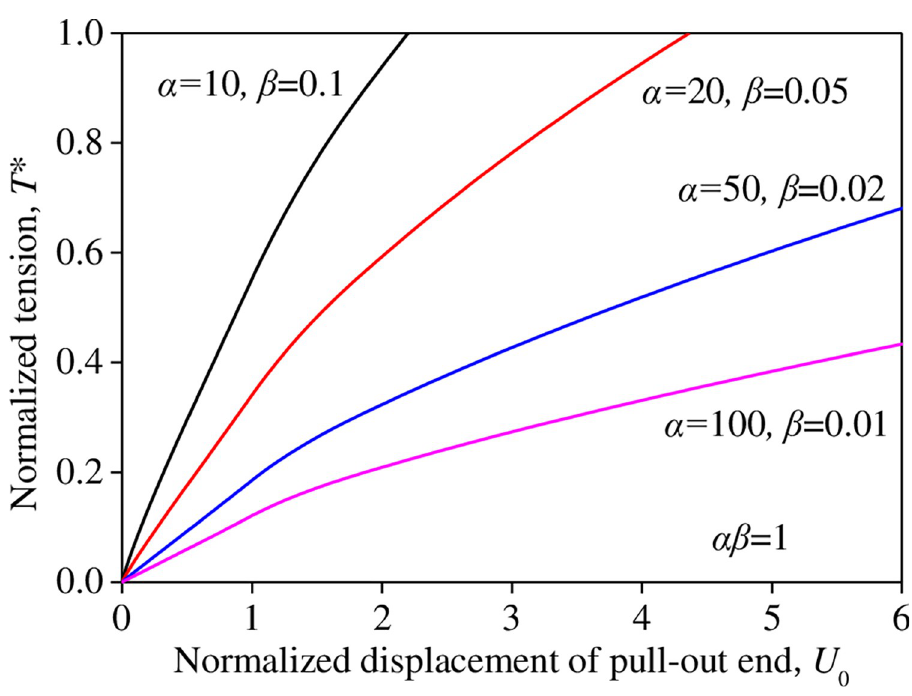
Fig 12. Influence of αβ on the T � –U 0 relation ( αβ =